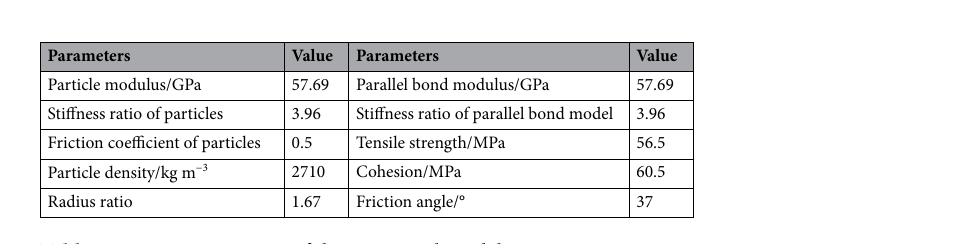
Table 3. Micro parameters of the numerical